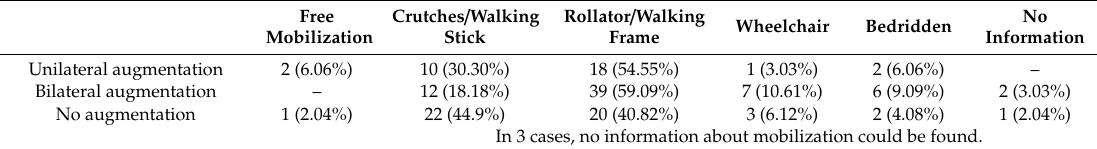
Table 4. Mobilization at time of discharge in dependence of